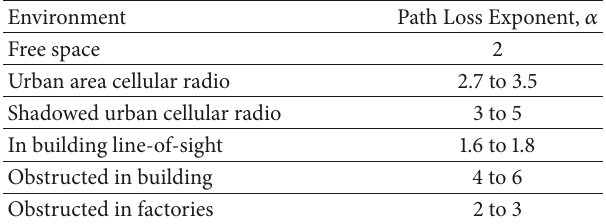
Table 2: Path loss exponents for different